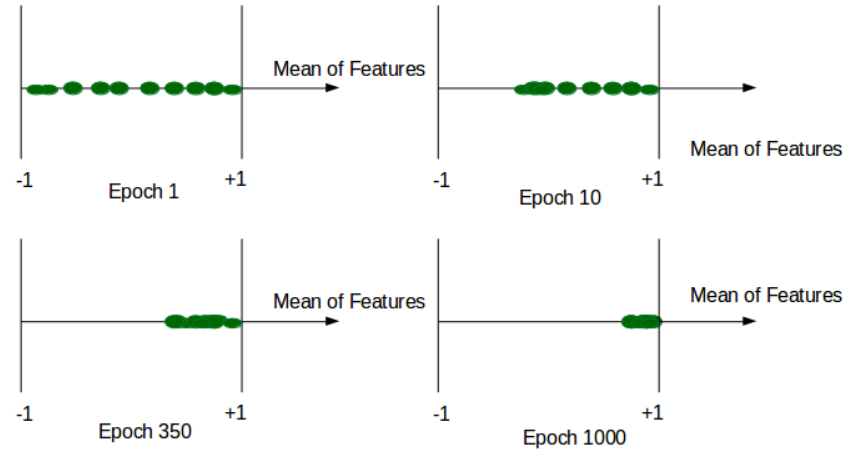
Figure 2. Average features during